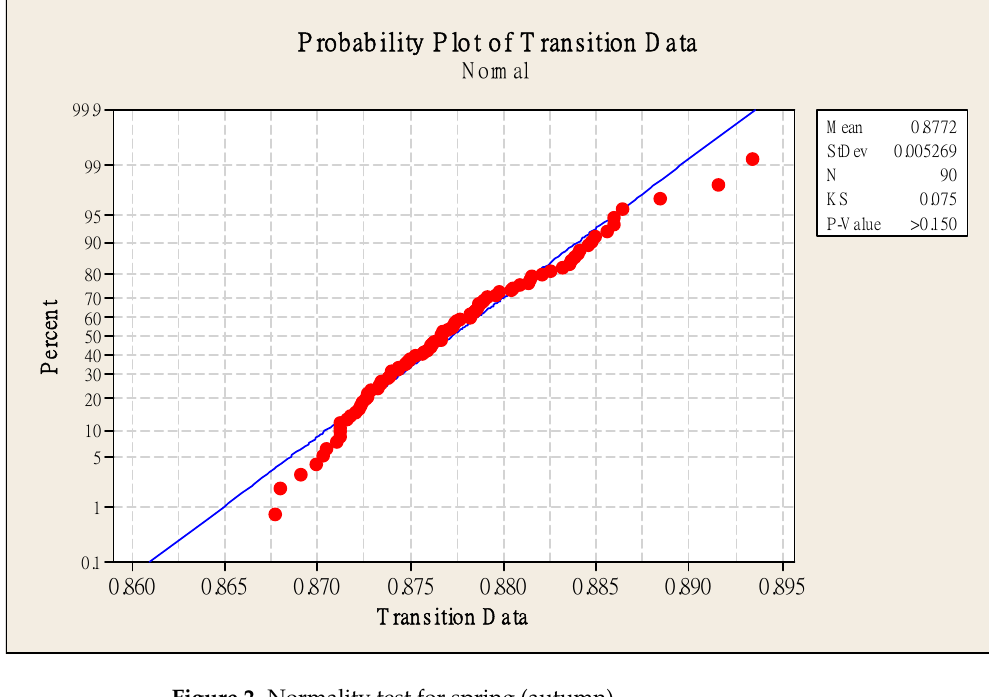
Figure 2. Normality test for spring (autumn).